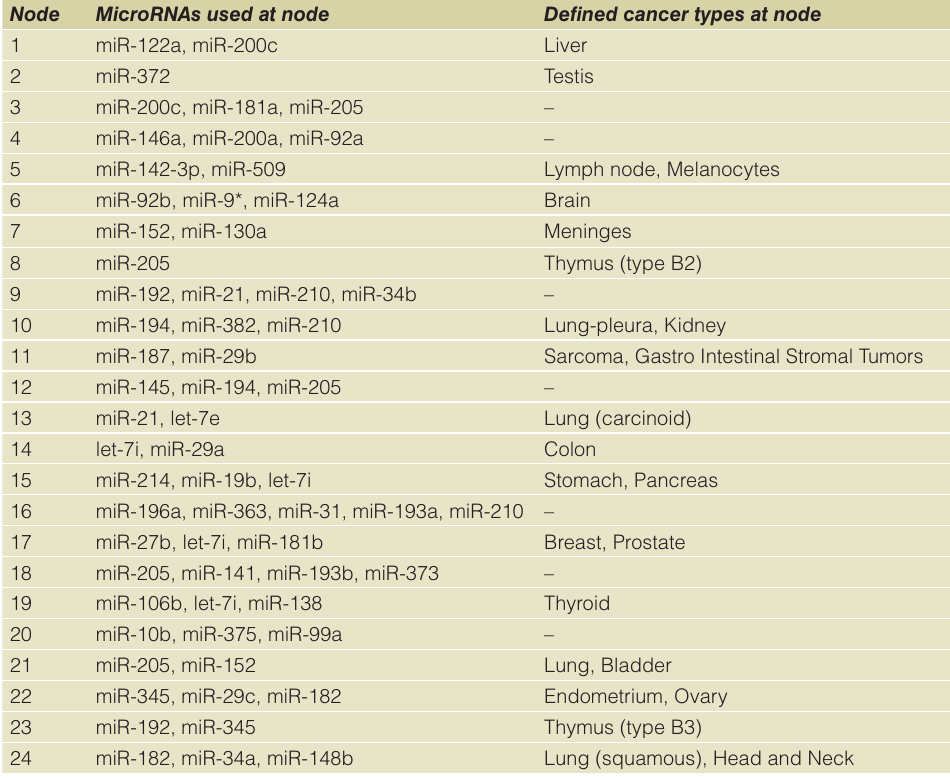
Table 1. Rosetta Genomics initial binary tree classifier consisting of 24 nodes giving rise to 25 leaves or defined cancer types. Each node uses 1 to 5 miRNAs for classification. Nodes giving no defined cancer types make broader distinctions. For example, Node #3 distinguishes epithelial tissues from mixed origin. Table is adapted from Rosenfeld et al.